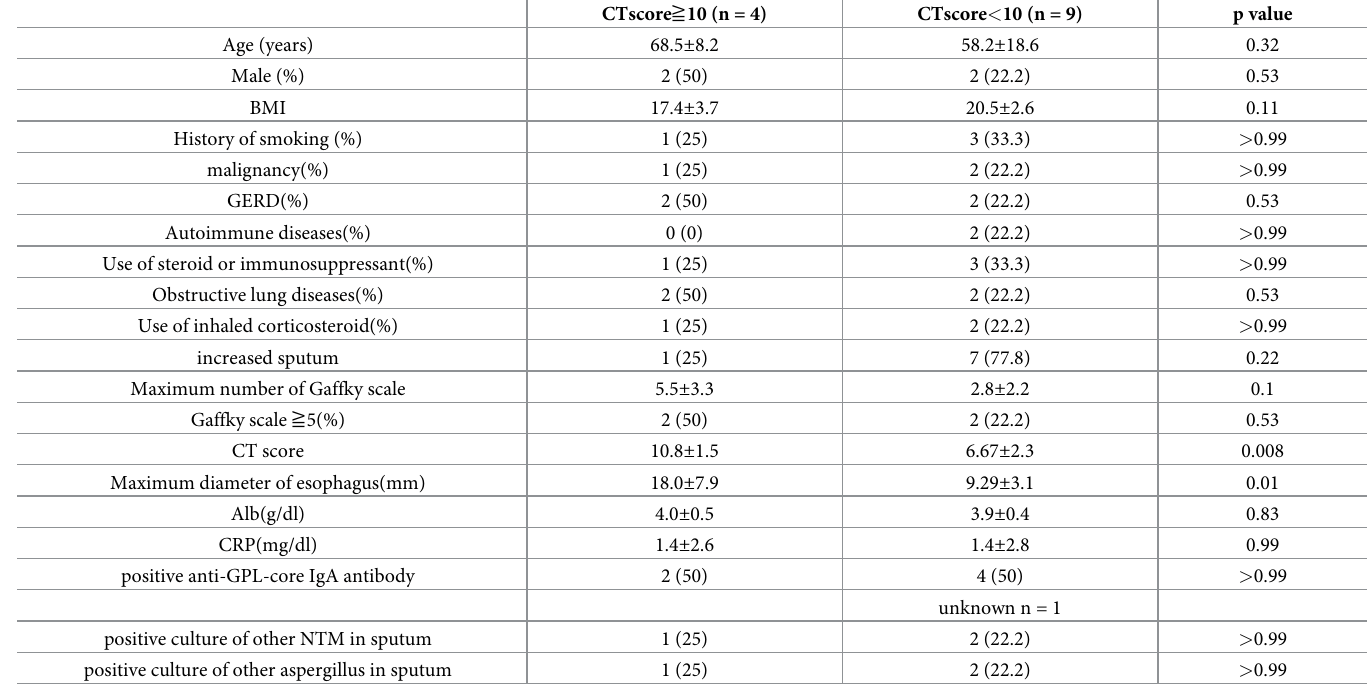
Table 2. Comparison of clinical characteristics of patients with severe disease and milder disease.